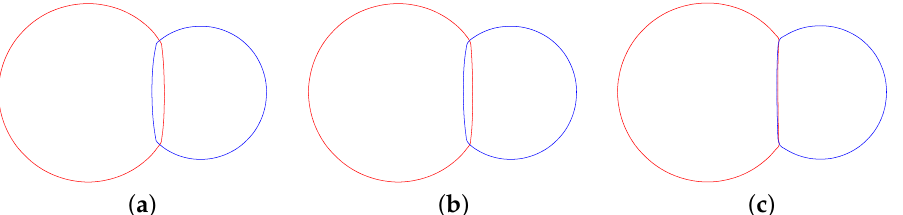
Figure 4. The evolution of our method in the cut view. ( a – c ) The contours from t = 0, 1, 5.5 in the cross-view,